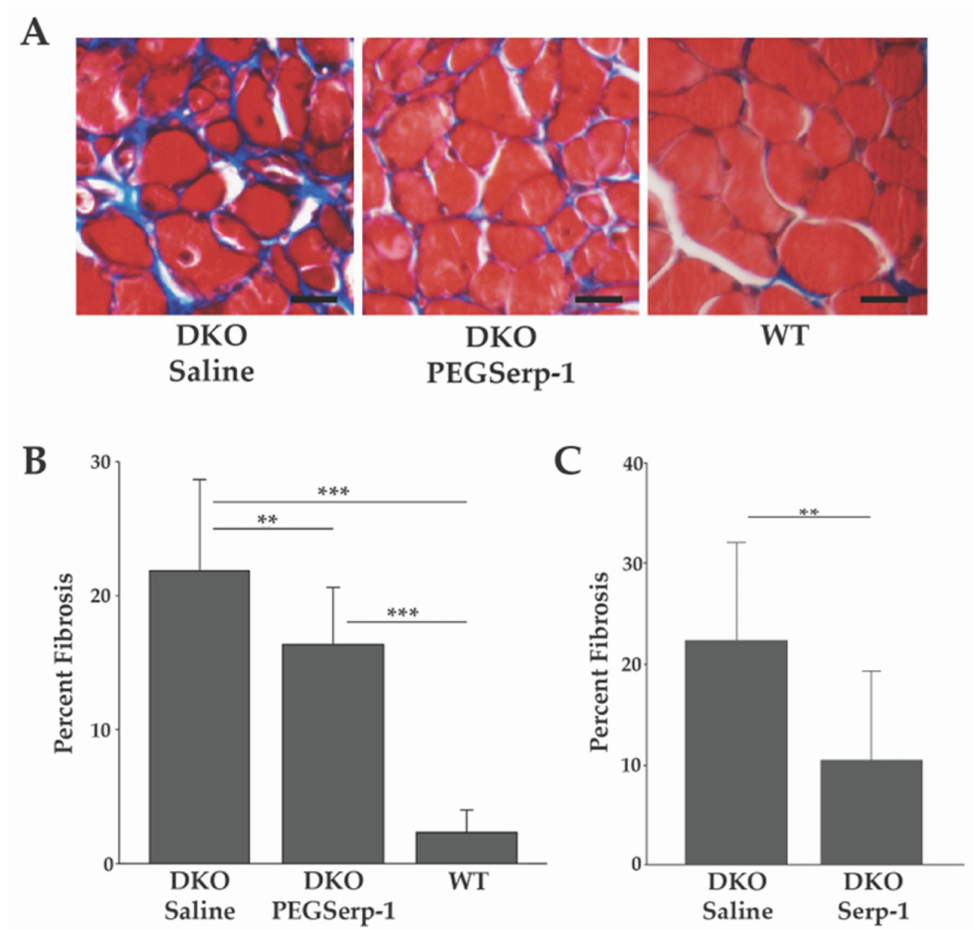
Figure 1. PEGSerp-1 treatment reduces skeletal muscle fibrosis. ( A ) Diaphragms stained with Masson’s trichrome. Note the collagen deposition (blue). ( B ) Fibrosis was measured as the average percent area per field ± s.d. using ImageJ ( n = 29 fields per treatment group). ( C ) DKO mice treated with native Serp-1 protein or saline were similarly analyzed. PEGSerp-1/Serp-1-treated diaphragms had decreased fibrosis. ** p < 0.01, *** p < 0.001. Scale bars = 10 µ